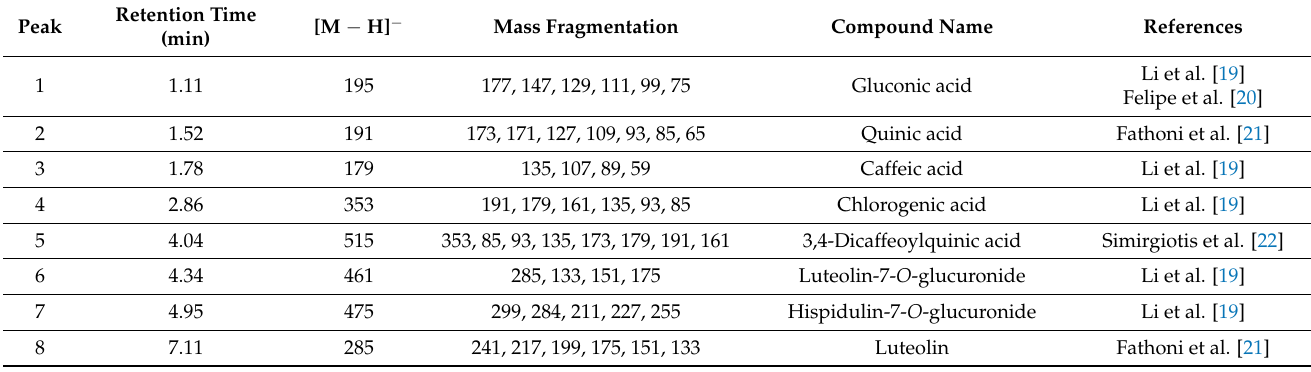
Figure 6. MRM chromatogram (TIC) of the Erigeron annuus (L.) Pers. water extract (EAW) by the LC-MS/MS method. Peak 1, gluconic acid; Peak 2, quinic acid; Peak 3, caffeic acid; Peak 4, chlorogenic acid; Peak 5, 3,4-dicaffeoylquinic acid; Peak 6, luteolin-7- O -glucuronide; Peak 7, hispidulin-7- O -glucuronide; Peak 8, luteolin. Table 4. Summarization of mass spectra data of flavonoids and polyphenols in EAW.